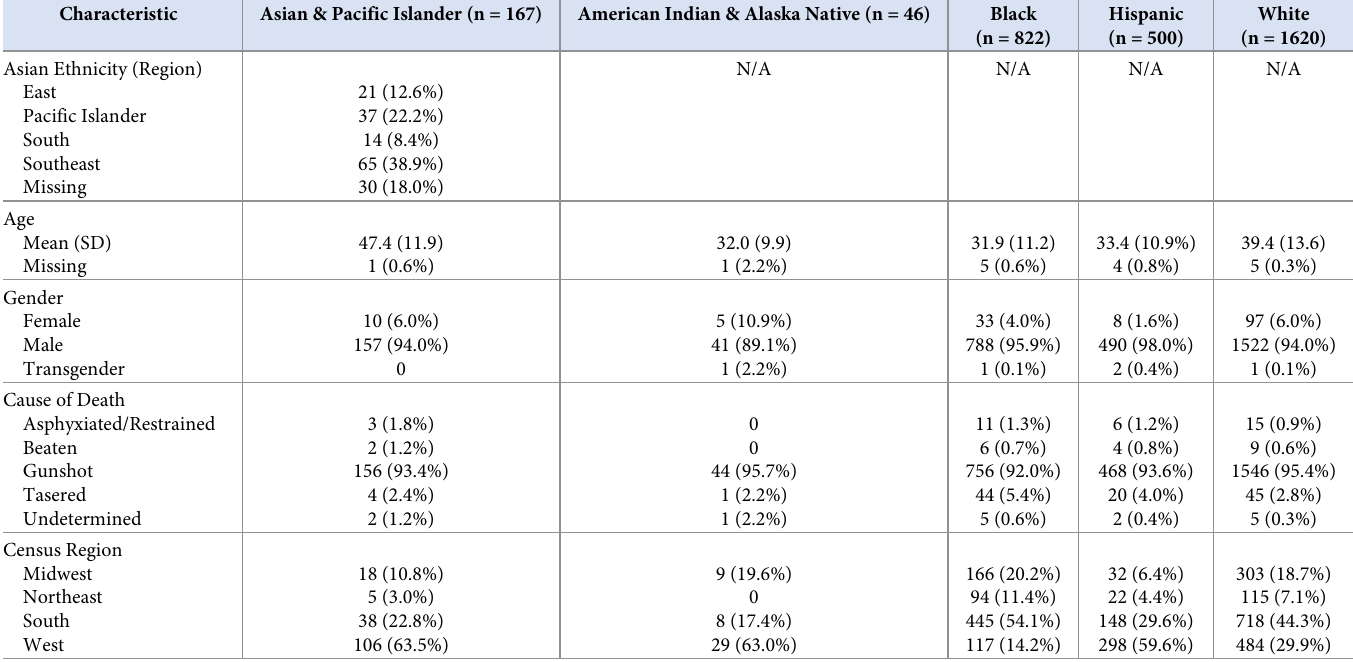
Table 1. Characteristics of police violence fatalities,